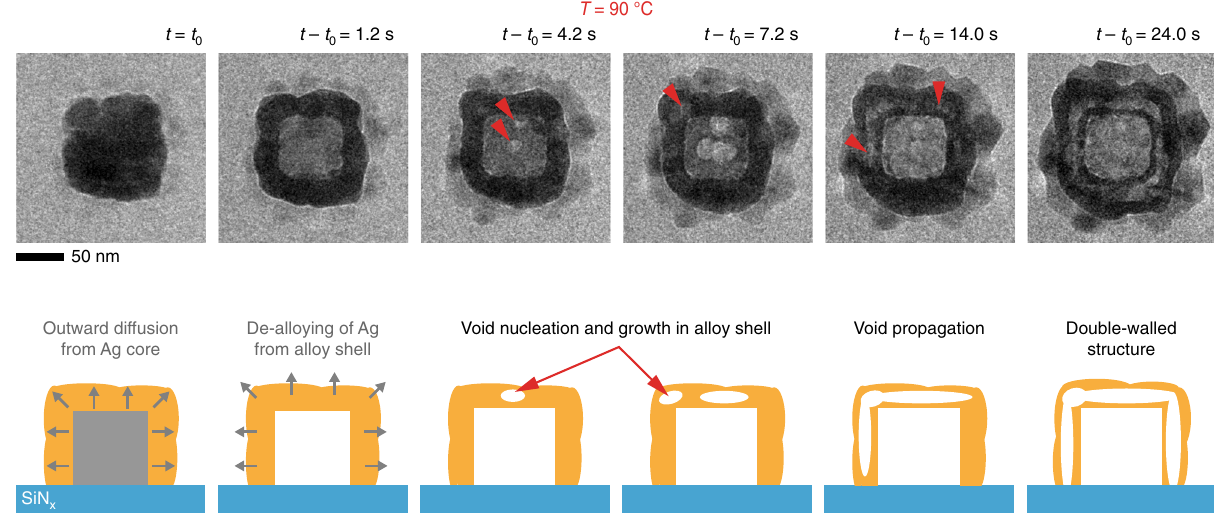
Fig. 4 GR of an Ag nanocube using an AuCl precursor solution at 90 °C. Time series of in situ TEM images (Supplementary Movie 4) and the corresponding schematic depicting the creation of double-walled structures via void nucleation and propagation within the alloy shell. Red arrows indicate the nucleation of voids and their propagation within the